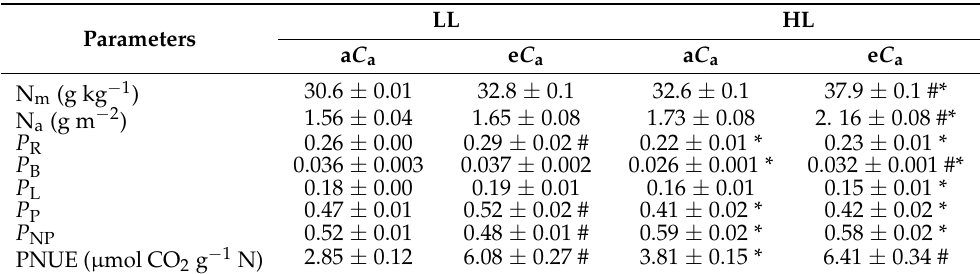
Table 1. The effect of light intensity [low (LL) or high (HL) light] and CO 2 supply [ambient (a C a ) or elevated (e C a )] on nitrogen traits of coffee plants: foliar N on a per mass (N m ) and area (N a ) basis, the leaf N fractions that were allocated into the major photosynthetic components [(RuBisCO ( P R ), bioenergetics ( P B ), and thylakoid light-harvesting components ( P L )], the N fraction that was allocated into the photosynthetic machinery ( P P ), and the fraction of N that was partitioned into non- photosynthetic components ( P NP ). The photosynthetic N-use efficiency is also shown. Asterisk (*), when shown, indicates differences between light regimes within the same CO 2 supply. Pound (#), when shown, indicates differences between CO 2 treatments within the same light regime ( p ≤ 0.05, F test, n = 6 ±